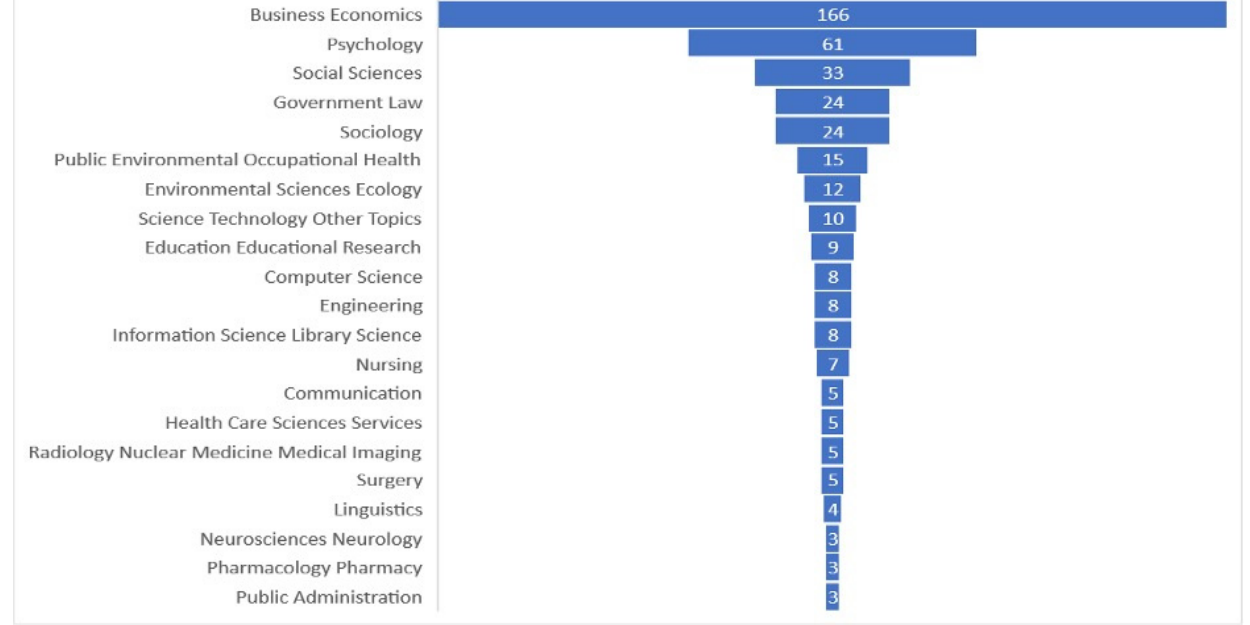
Figure 10. Most relevant thematic areas.